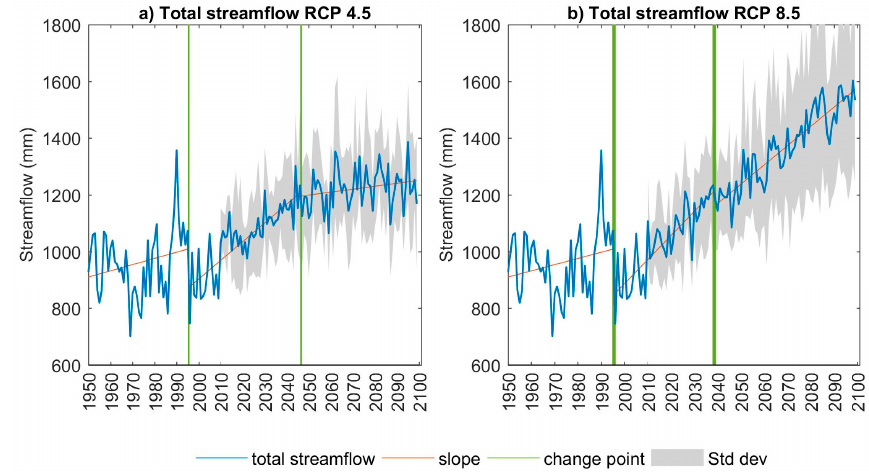
Figure 11. Future trends in total streamflow for RCP 4.5 and RCP 8.5 (MM45 and MM85). Total streamflow is the sum of runoff from all sources. The vertical green lines indicate break points in the slope of total runoff.